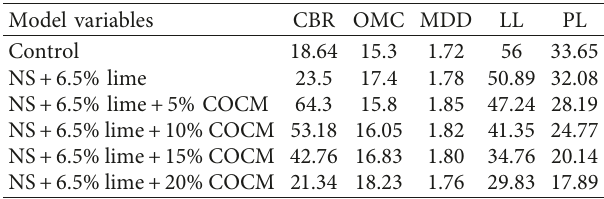
probability plot of the residuals in percent, the fitted value vs. residuals ranging from 1.0 to 1.0, frequency distribution − histogram of the residuals and the residuals against the observation order (%) [65, 66].